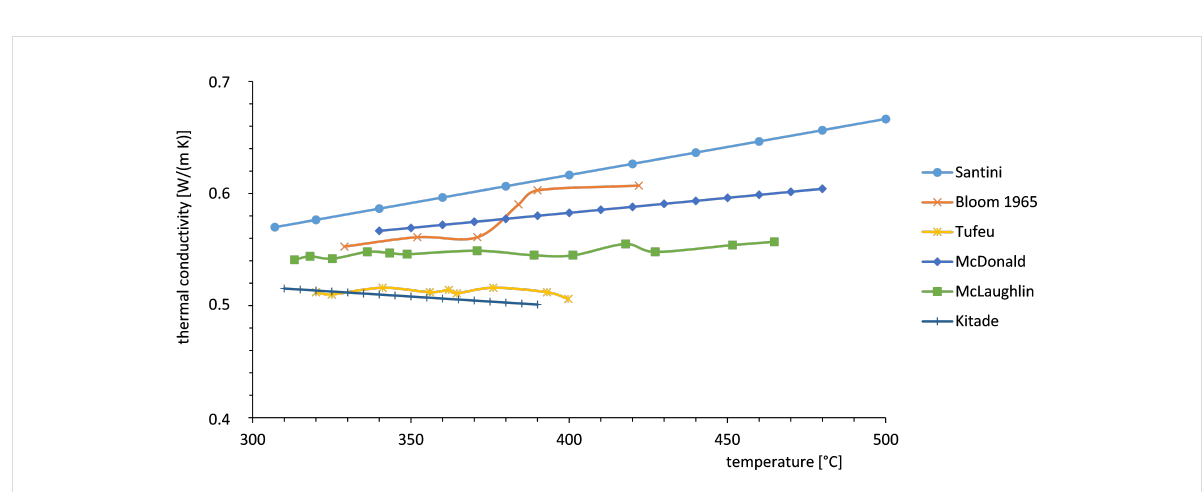
Figure 10: Density of NaNO 3 [16,30-32].